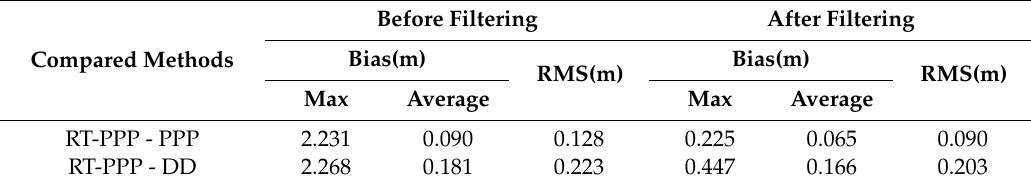
Figure 10. Comparison of RT-PPP tide measurement results (red) with the post-processing PPP method (green) and double difference (DD) method (blue). ( a ) ( b ) Show the instantaneous sea level, ( c )( d ) show filtered tide values. Table 3. Comparison of RT-PPP tide measurement results before and after filtering with the post-processing PPP method and the DD method.